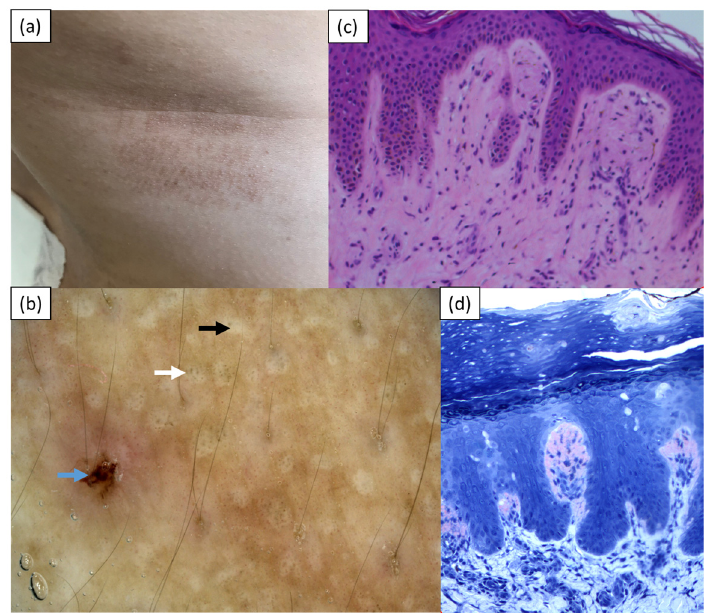
Figure 1. Case 1—( a ) brown coalescing papules on the right side of the trunk; ( b ) videodermoscopy showing central white hubs (black arrow) with greyish dots (white arrow) and a single erosion (blue arrow); ( c ) histopathological examination showing hyperkeratotic epidermis, pigment incontinence, and deposits of eosinophilic material in the papillary dermis (hematoxylin & eosin); ( d ) deposits in the papillary dermis staining positive with Congo red.